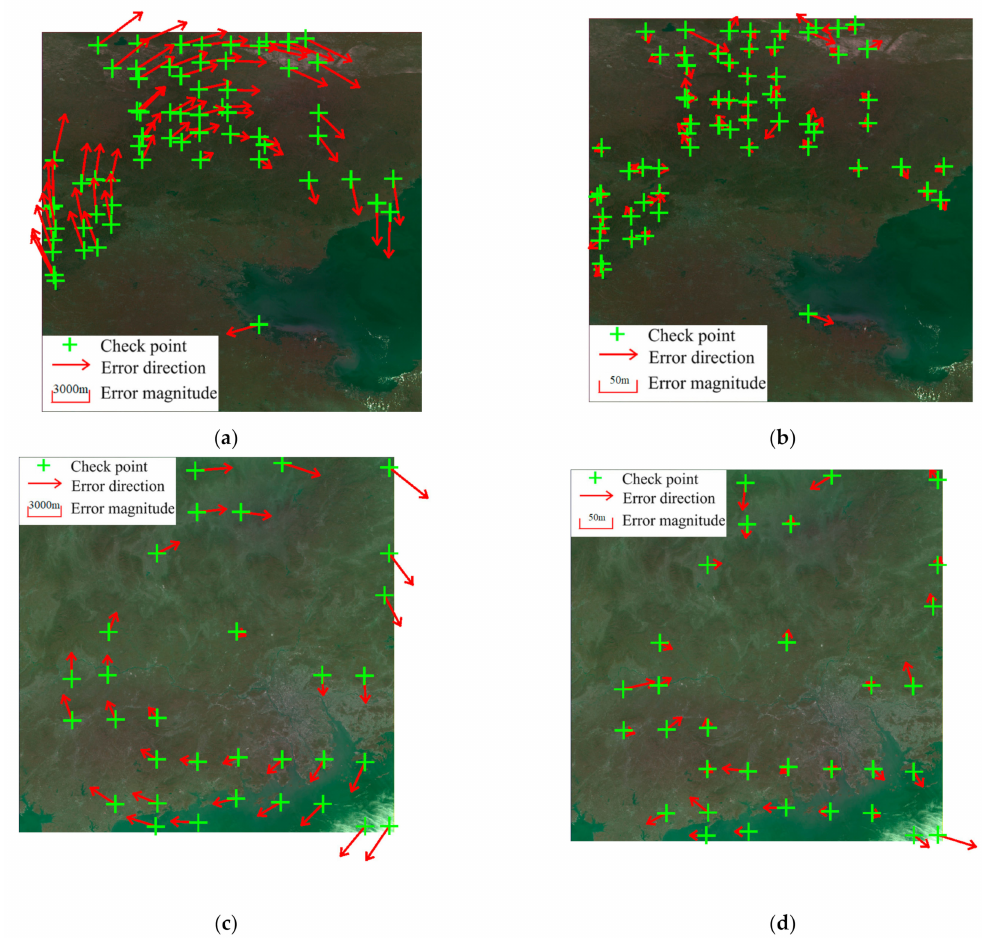
Figure 7. The relative errors and their directions of checkpoints. Errors of an image ( a ) on 28 August 2016 before removing the external geometric accuracy; ( b ) on 28 August 2016 after removing the external geometric accuracy; ( c ) on 21 December 2020 before removing the external geometric accuracy; ( d ) on 21 December 2020 after removing the external geometric